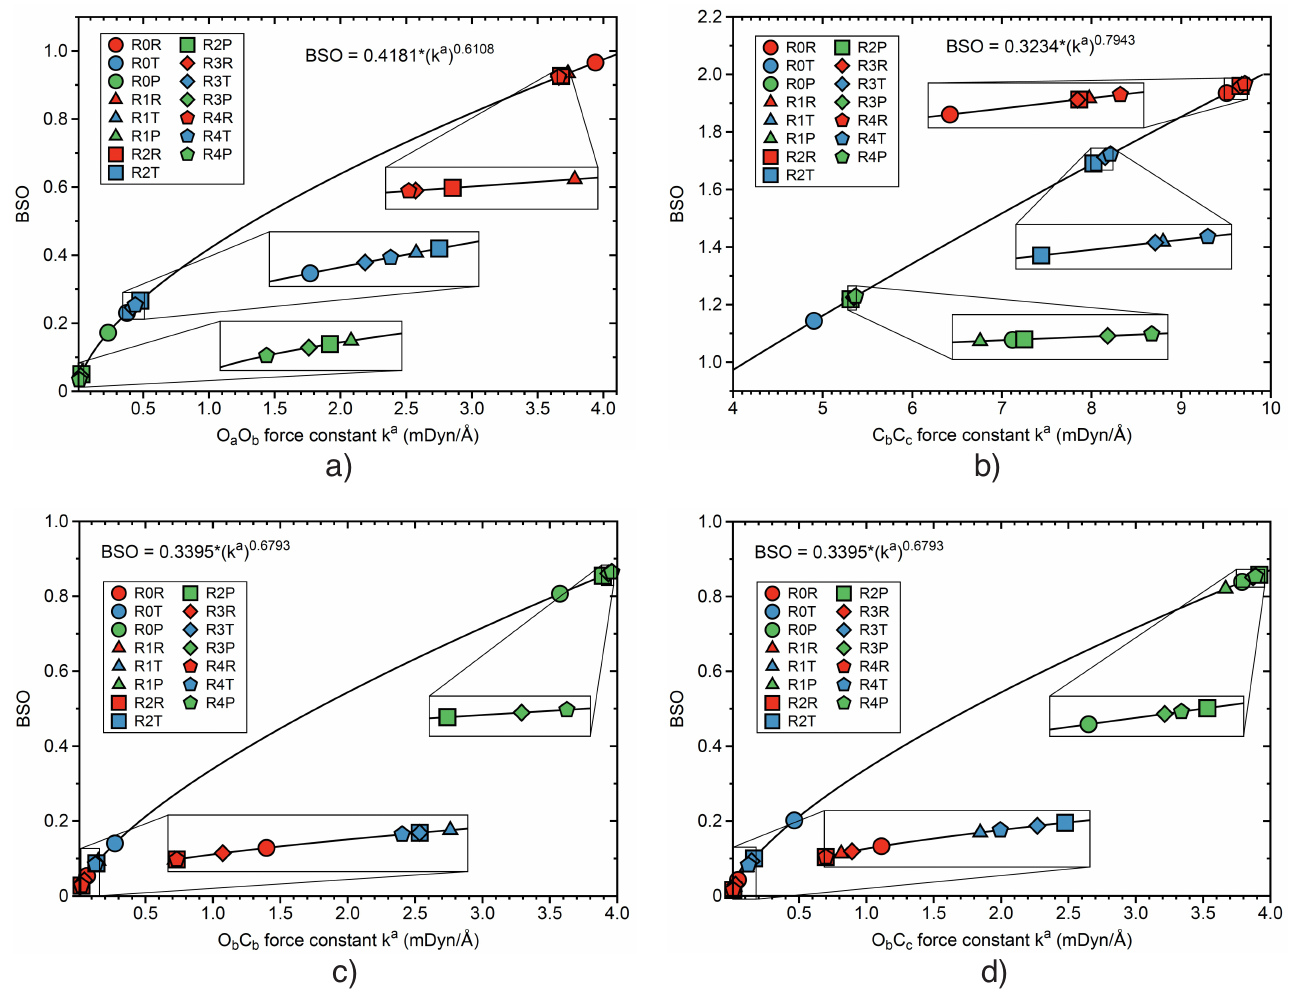
d) Figure 9. BSO as a function of k a . ( a ) OO bonds, ( b ) CC bonds, ( c ) O b C b and ( d ) O b C c epoxide bonds (for atom labels, see text). RnR, RnT and RnP indicate the reactant (red color), TS (blue color) and product (green color) for reactions Rn , with n=0, · · · 4. B3LYP/6-31G(d,p)/SDD(Ti) level of